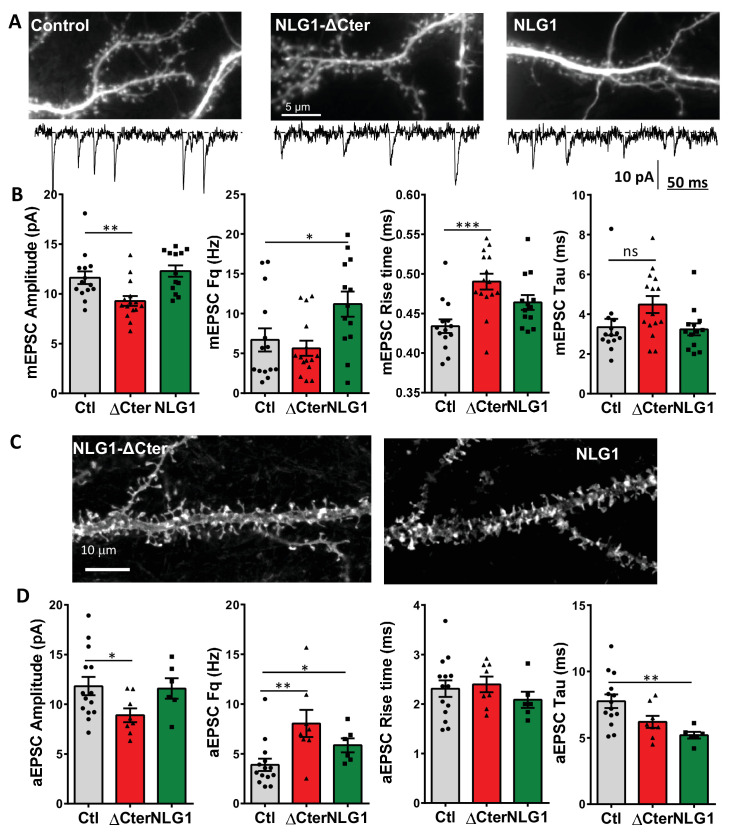
Neuroligin 1 and NLG1-ΔCter expression have various effect on synaptic transmission properties both on neuronal cell culture and organotypic slices.(A) Representative images from control and NLG1 and NLG1-ΔCter expressing neurons in culture, with an expanded miniature trace example. (B) Analyses of miniature EPSC, from left to right are represented the amplitude, the frequency, the 20–80% rise time and the decay time constant. (C) Representative images from NLG1 and NLG1-ΔCter expressing neurons in organotypic hippocampal culture. (D) Analyses of asynchronous EPSC, from left to right are represented the amplitude, the frequency, the rise time and the decay time. For all figures, the control is represented in dark, the NLG1-ΔCter in red and the NLG1 in green. Each dot represents the mean value for an individual cell.